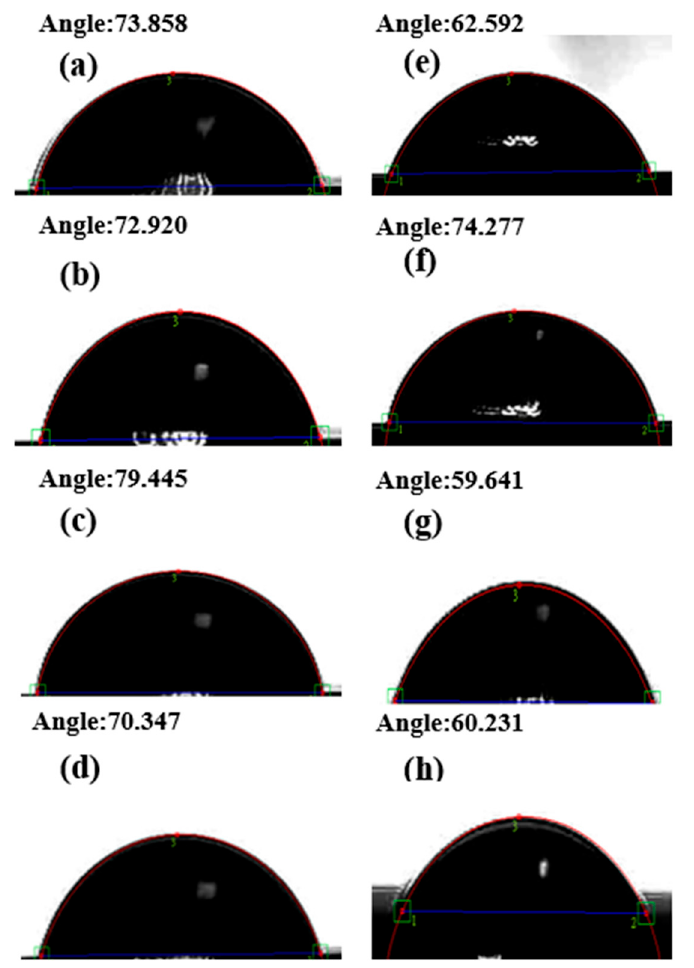
Figure 8. Contact angles of the Co 40 Fe 40 V 10 B 10 thin films with DI water: ( a ) 10 nm, ( b ) 20 nm, ( c ) 30 nm, and ( d ) 40 nm. Contact angles of the Co 40 Fe 40 V 10 B 10 thin films with glycerol: ( e ) 10 nm, ( f ) 20 nm, ( g ) 30 nm, and ( h ) 40 nm.